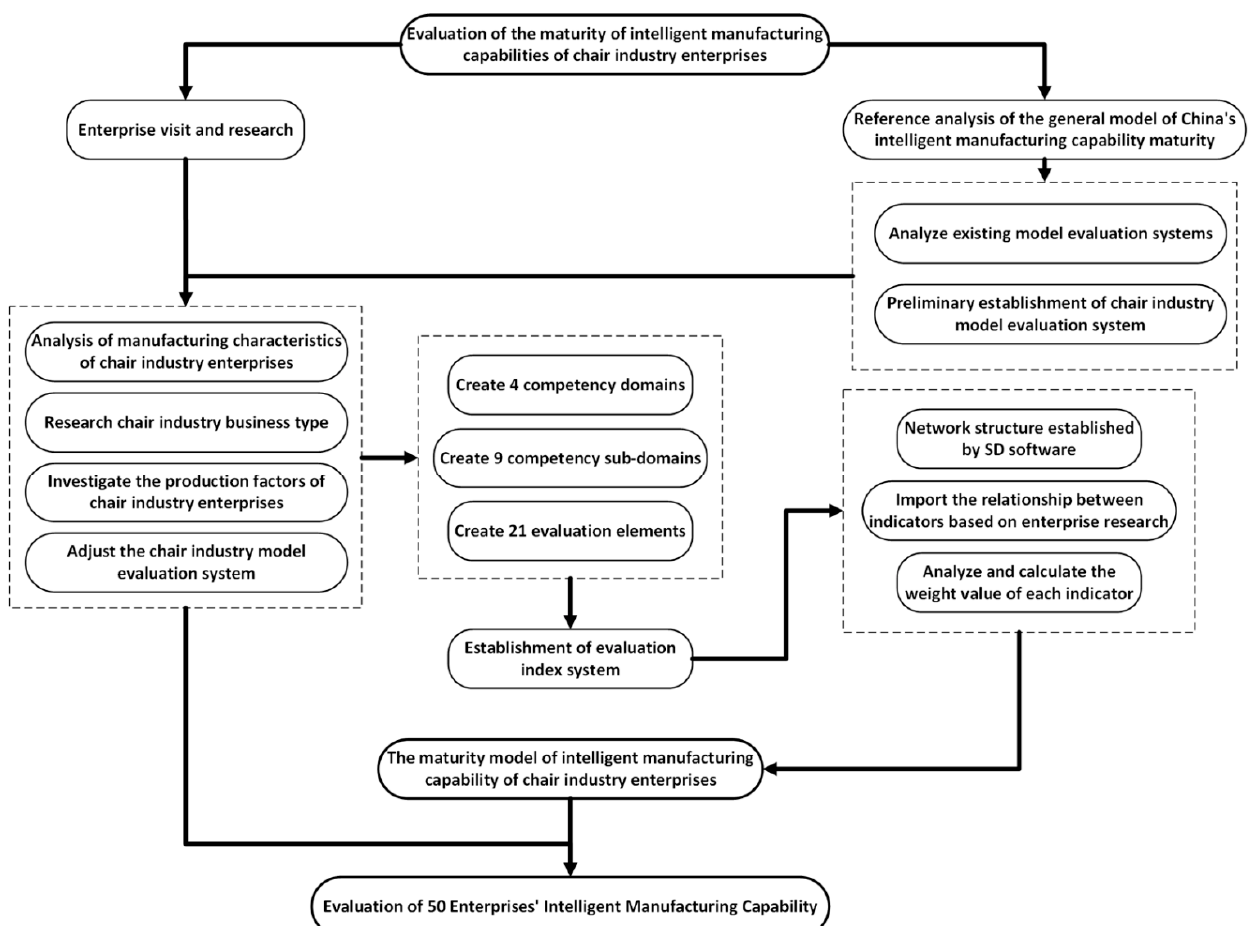
Figure 1. Workflow block diagram.